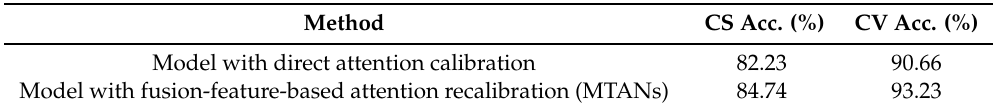
Table 5. Performance comparison between the model with direct attention recalibration and the model with fusion-feature-based attention recalibration on the NTU RGB+D dataset.